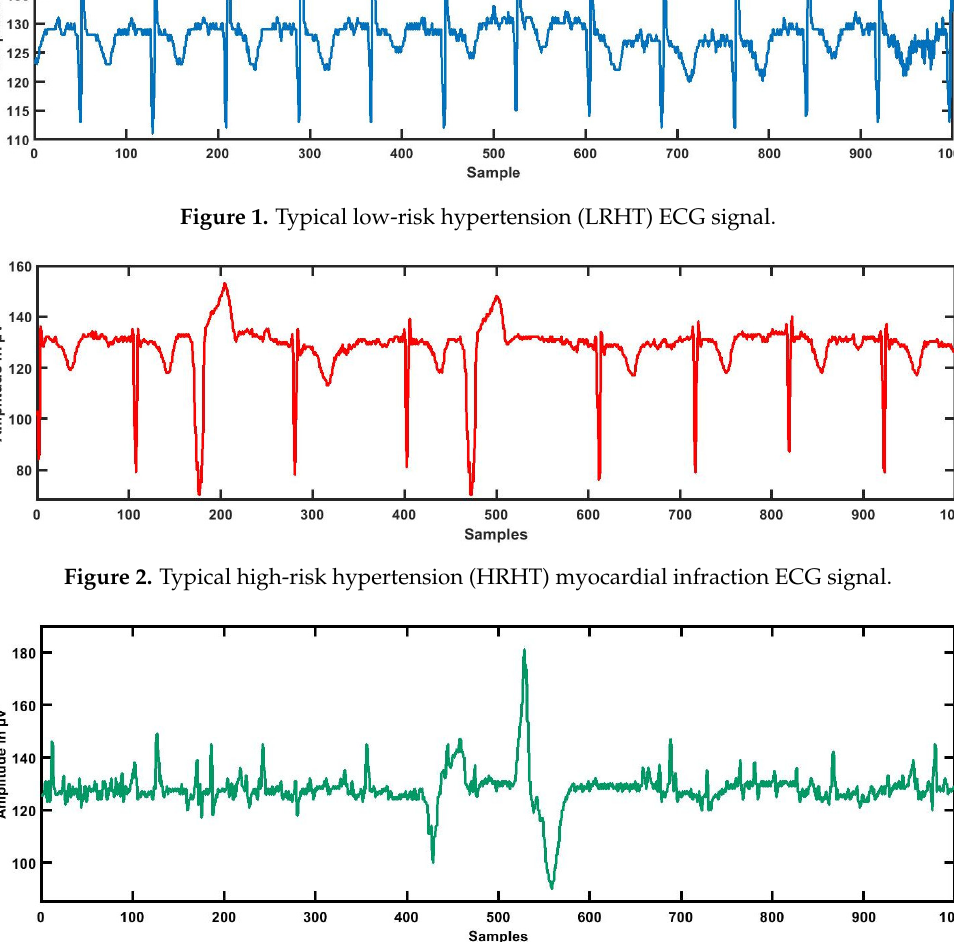
Figure 3. Typical high-risk hypertension (HRHT) syncope ECG